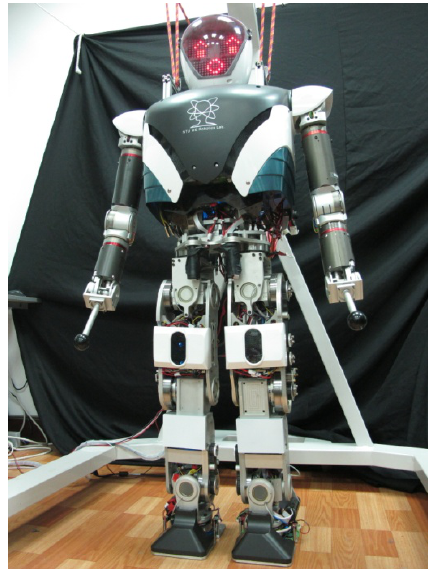
Figure 19. The humanoid robot, Nino.